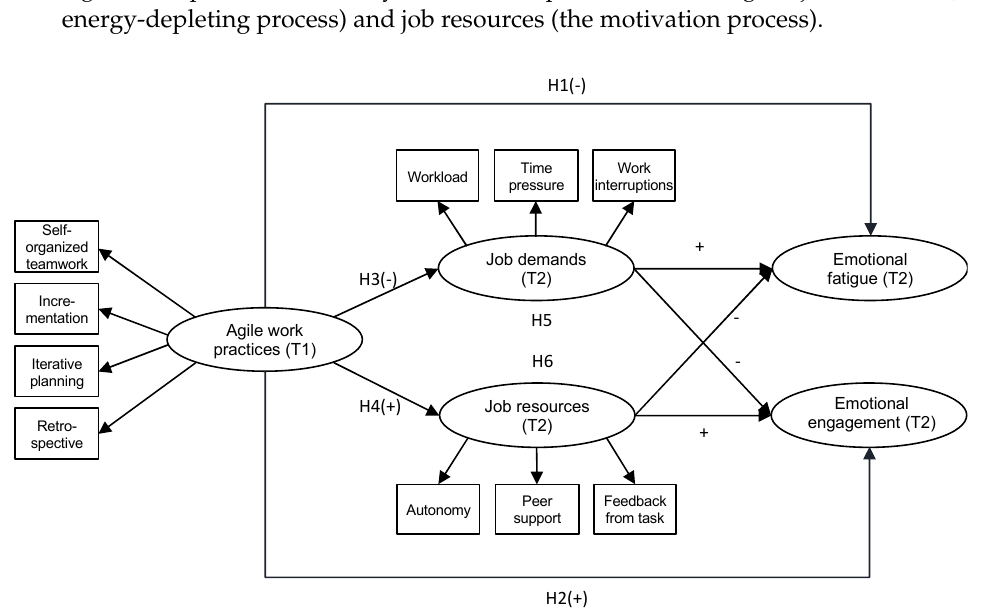
Figure 1. The hypothesized job demands–resources model for agile work practices.